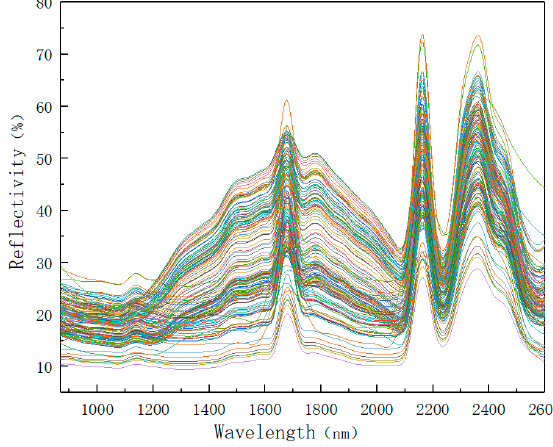
Figure 7. A total of 143 spectral graphs smoothed by the loess method. Table 3. Experimental parameter setting table.